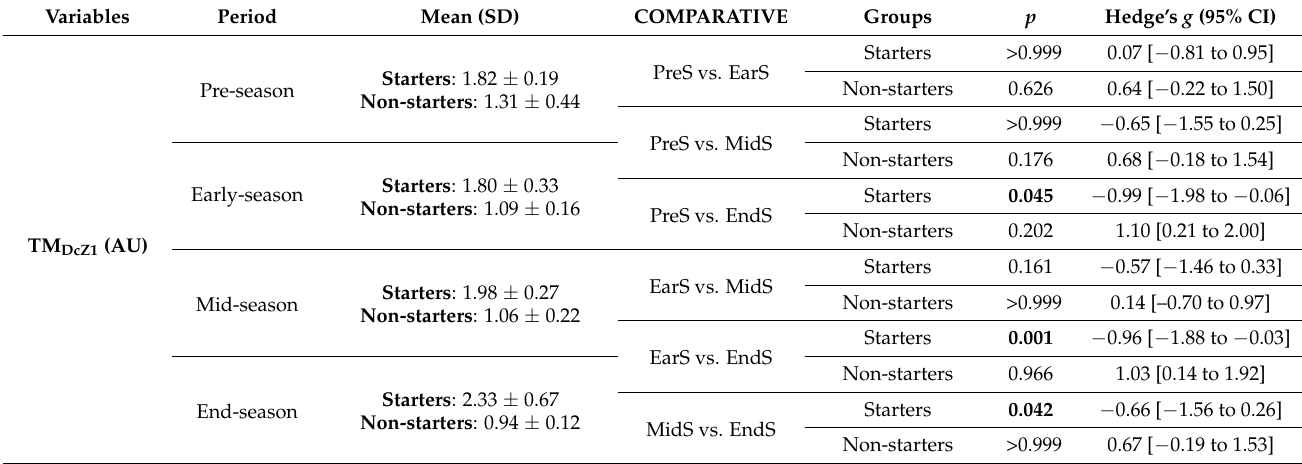
Table 4. Intragroup differences for binary comparisons between season periods in TM and TS in DcZ1 for both non- and starter